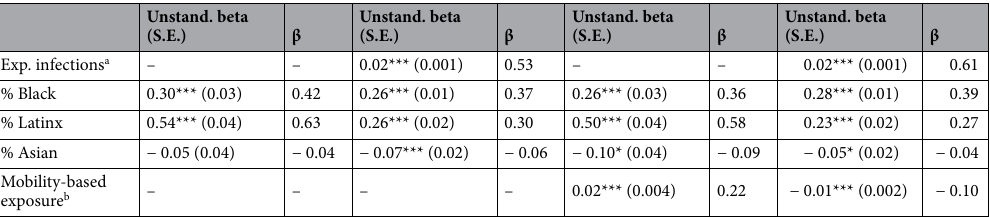
Table 1. Parameter estimates from regression equations using demographic composition, mobility-based exposure, and expectations from the no-vaccine scenario to predict infection rates at the end of the vaccination simulation. For 128 communities, defined as the municipalities of the greater Boston region and the ZIP codes within Boston. * p < .05; *** p < .001. a Based on rates in the no-vaccine scenario. b Potential exposure to infection transmission via movement between communities, as derived from the model